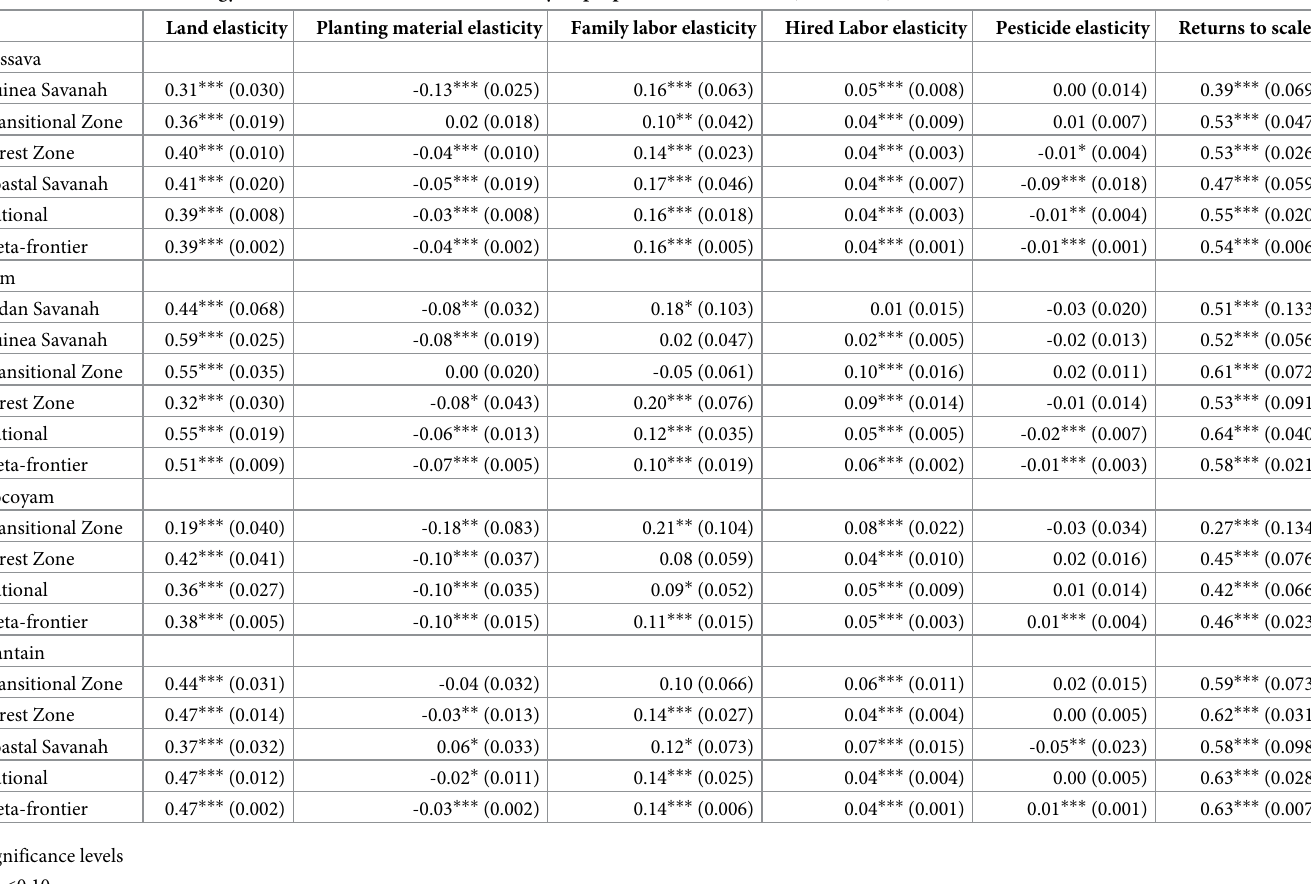
Table 3. Elasticities for ecology- and meta-frontier models for starchy staple production in Ghana